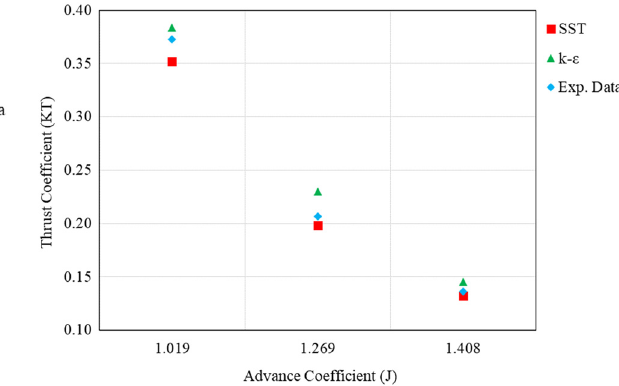
Figure 13: Numerical results of torque coe ffi